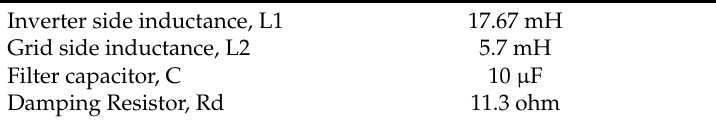
Table 1. Parameters for LCL filter design.